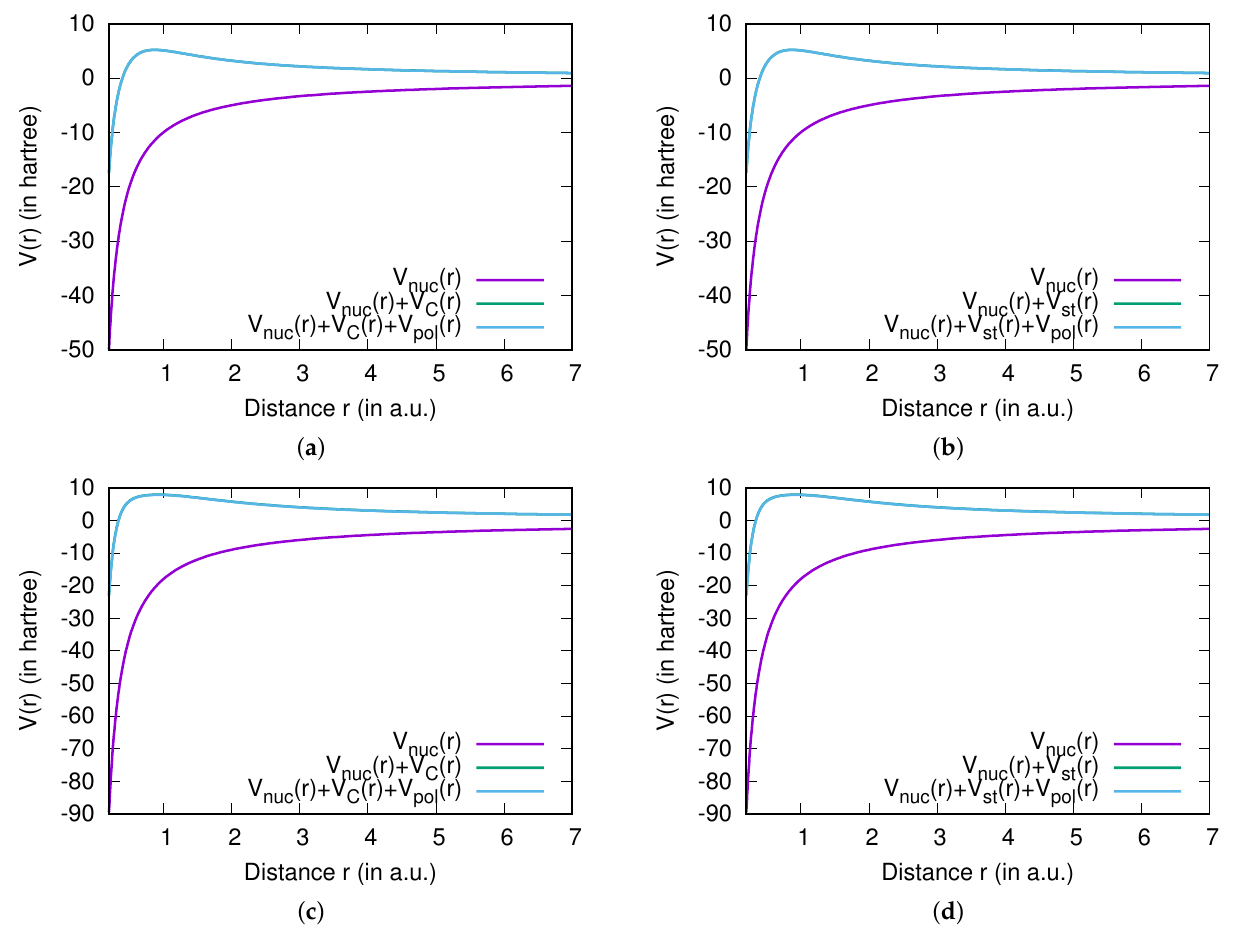
Figure 4. Plots demonstrating different contributions to V ( r ) from the Ne and Ar noble atoms. In ( a , b ), results are given from the RCCSD and RNCCSD methods, respectively, for the Ne atom, while the results from the RCCSD and RNCCSD methods for the Ar atom are shown in ( c , d ), respectively. All quantities are given in